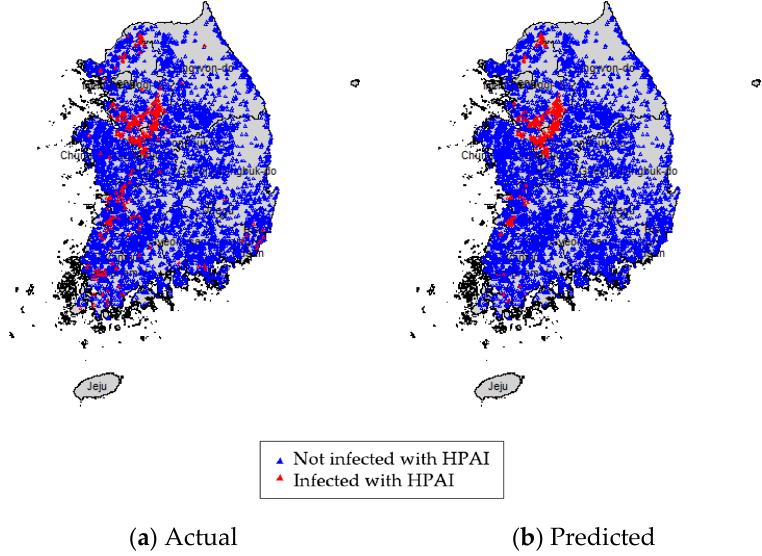
Figure 3. Spatial distribution of poultry farms. Actual ( a ) vs. Predicted ( b ) using the spatial random effects logistic model. Farms infected by HPAI are shown in red. Farms not infected by HPAI are shown in blue. Table 4. Moran’s I statistics. Spatial autocorrelation of the predicted probability of a farm being in- fected with HPAI among neighboring farms with respect to the distance between pairs of farms